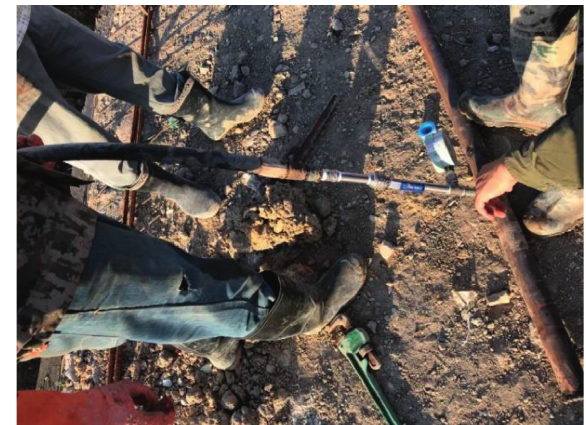
Figure 5: Water injection test